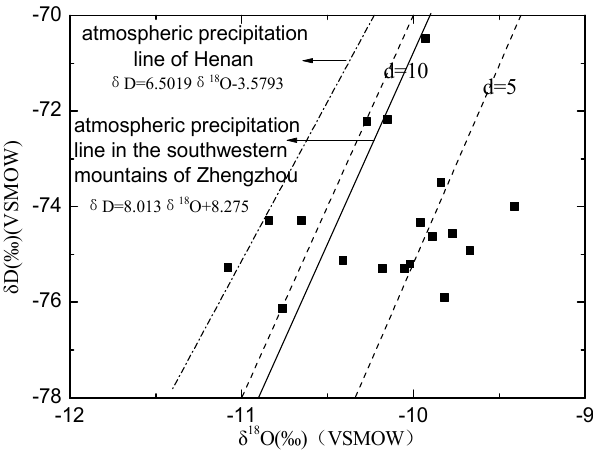
Figure 1. Relationship between δ D and δ 18 O and the characteristic of the d value in Kaifeng geothermal water.